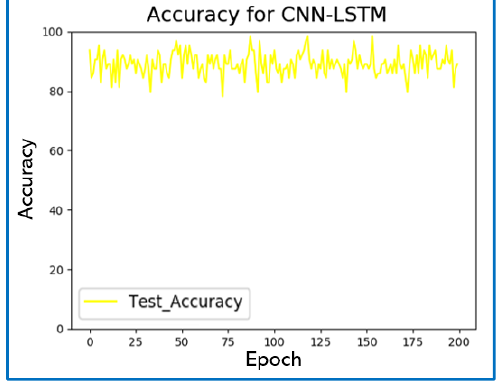
Figure 10. Train accuracy by CNN-LSTM algorithm.